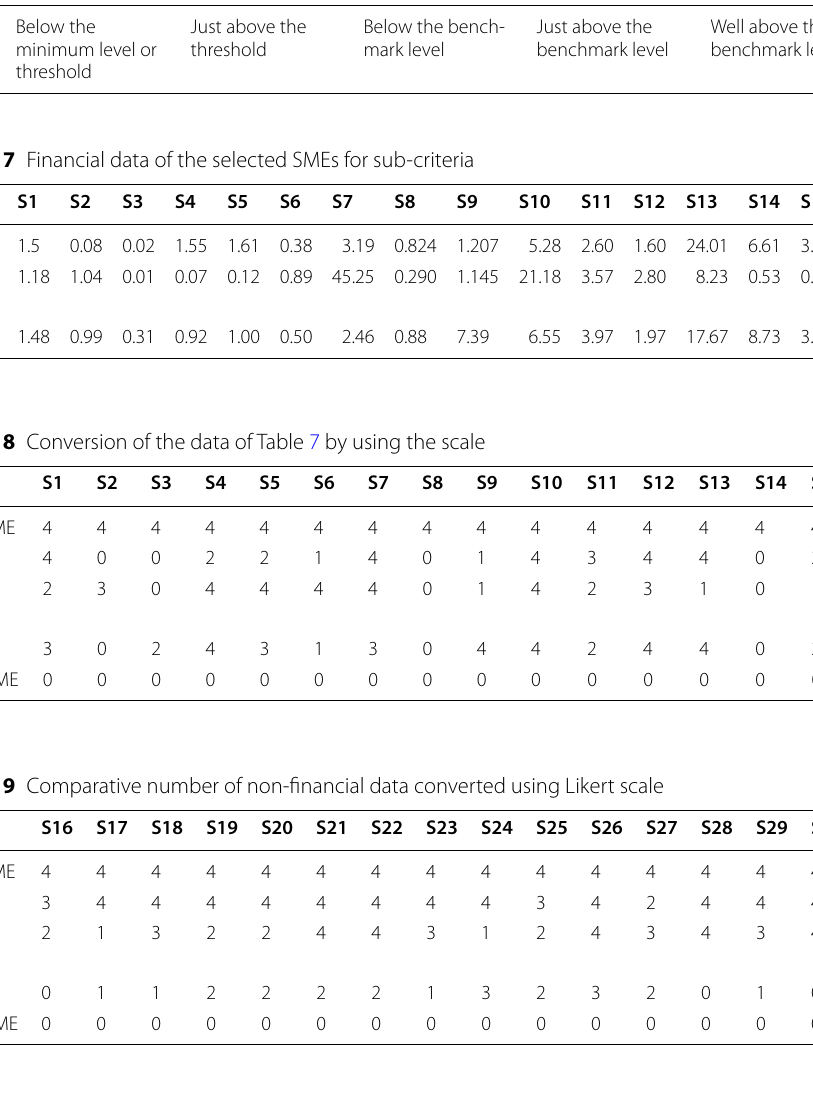
Table 6 The 5-point Likert scale Score 0